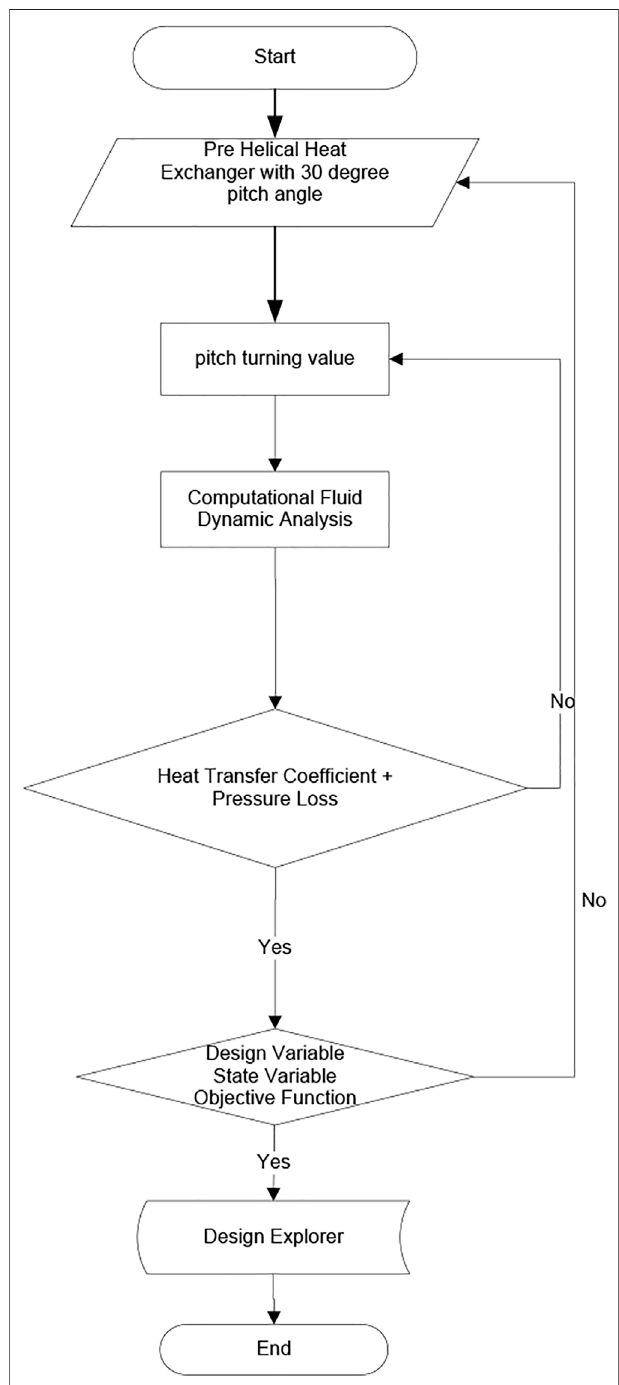
FIGURE 8 | Optimization procedure